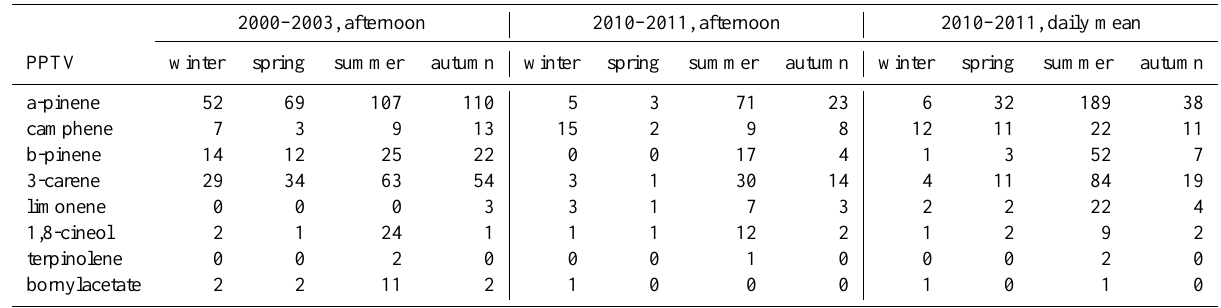
Table 2. Comparison of the present results (afternoon values only and daily means) to the earlier measurements (2000–2003) conducted at Hyyti¨al¨a (Hakola et al.,